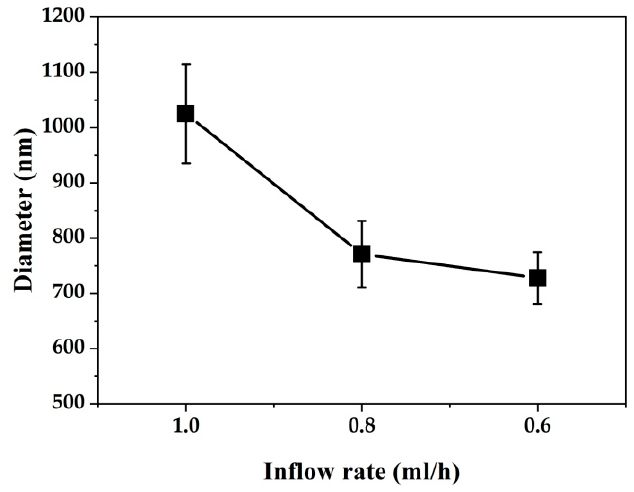
Figure 5. Average diameters of TiO 2 / ZnO nanofibers with inflow rate.